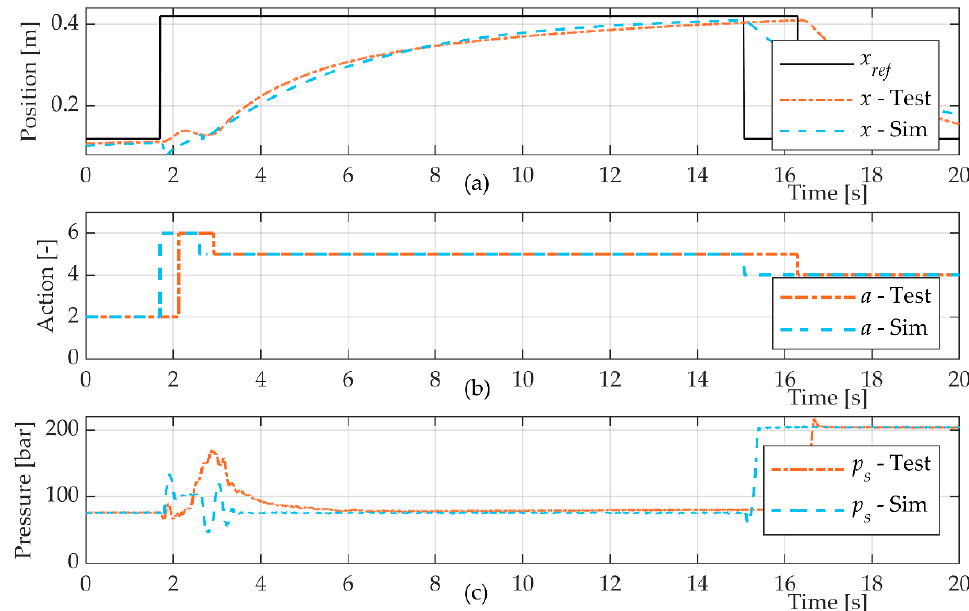
Figure 11. Experimental (Test) and simulation (Sim) results, 40 kg load and p LS ,1 = 60 bar. ( a ) position and reference; ( b ) action; ( c ) system pressure.